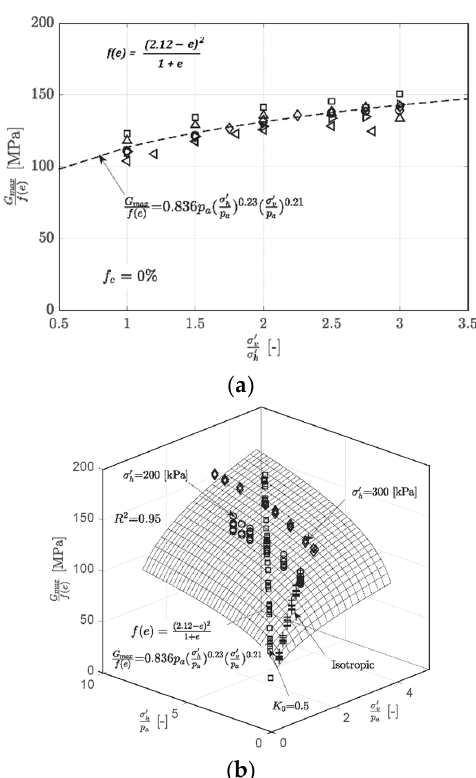
Figure 9. Prediction of the G max with different void ratios and fines content under ( a ) isotropic and ( b ) anisotropic stress states. The lines denote the best fits obtained using the Hardin void ratio equation, K H f ( e ) . N R (cid:9)((cid:11))